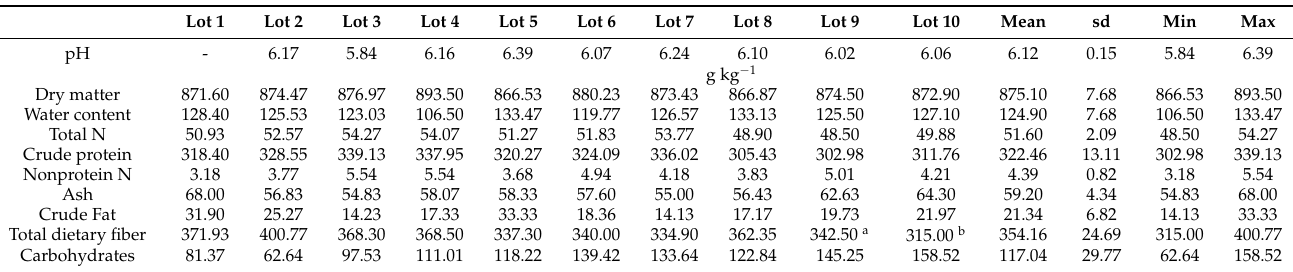
* data for each lot represent mean of triplicate measurements. Details on the origin of rapeseed meal and on lot sampling are provided in Section 3 and in Table S1. a Lot 9: Soluble fiber 43.5 ± 6.4 g kg − 1 , Insoluble fiber: 299.0 ± 9.9 g kg − 1 . Total dietary fiber =